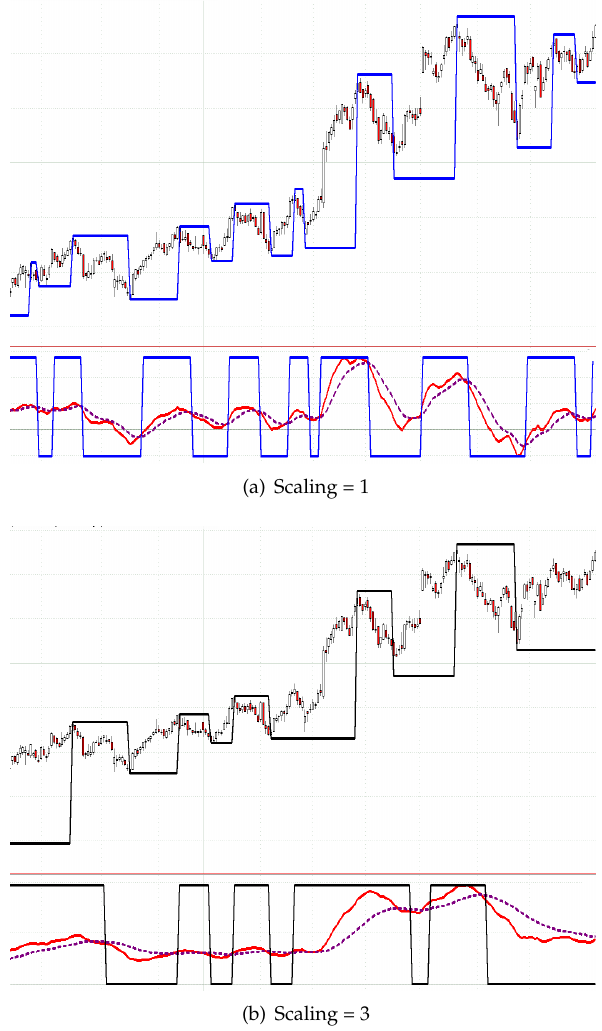
Figure 3. Daily chart of the Adidas stock between September 2012 and August 2013 with the MinMax-process by Maier-Paape ( a ) based on the integral moving average convergence divergence (MACD) stop and reverse (SAR)-process ( b ) with two different scalings: one and three. The lines in the charts indicate the last detected